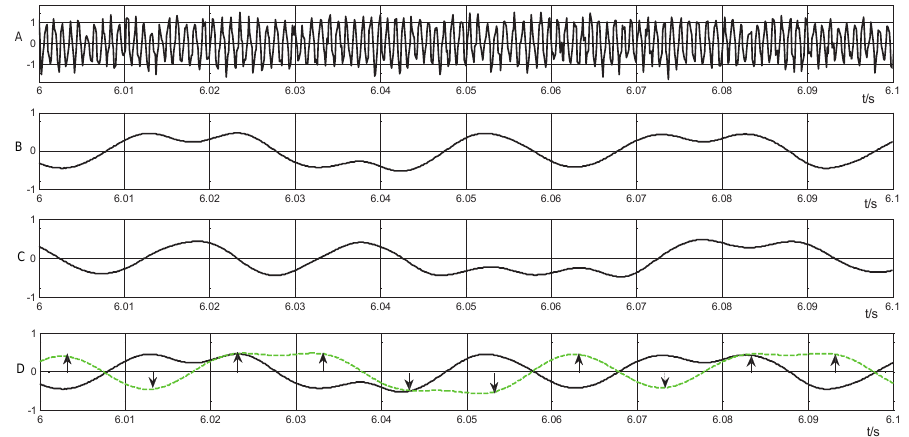
Figure 9. Simulation results of partial-respond demodulation system. ( A ): The transmitted signal corrupted with additive white Gaussian noise; ( B ): The baseband signal demodulated in the in-phase channel; ( C ): The baseband signal demodulated in the orthogonal channel; ( D ): The baseband signal through the matched filter and best sampling